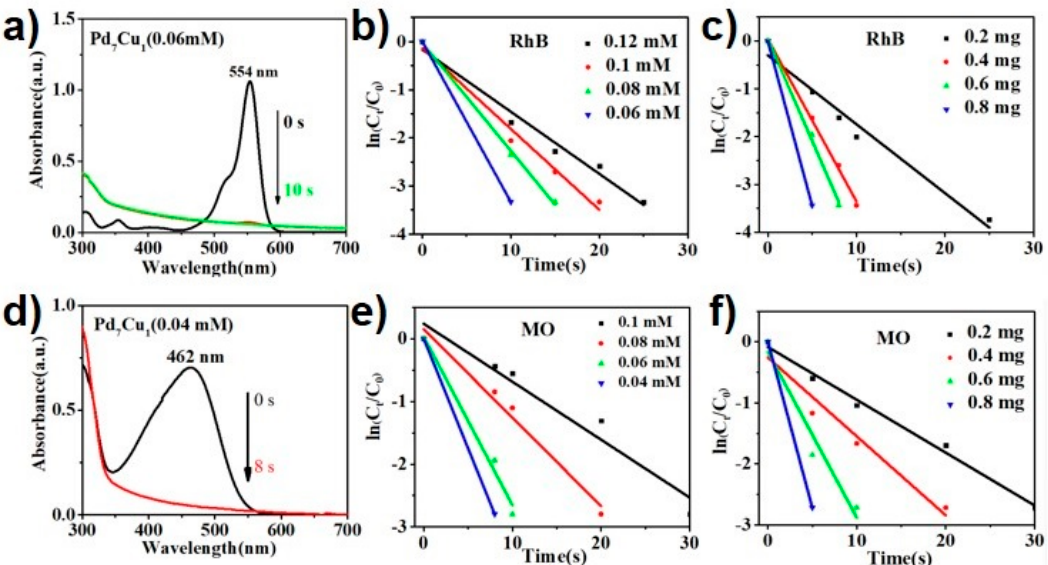
Figure 5. ( a , d ) Degradation of RhB/MO by Pd-Cu alloy NPs in UV- vis spectrum. ( b , c ) The pseudo- first-order kinetic linear simulation curves of ln(C t /C 0 ) versus reaction time for the catalytic degradation of RhB. ( e , f ) The pseudo-first-order kinetic linear simulation curves of ln(C t /C 0 ) versus reaction time for the catalytic degradation of MO.